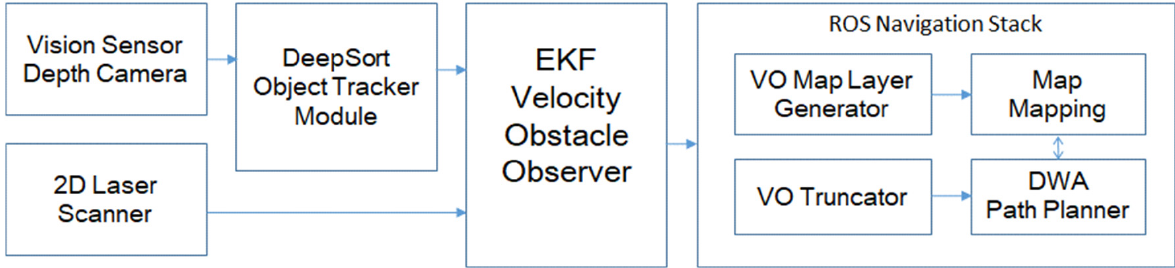
Figure 4. The velocity estimation and cost map generation workflow diagram.